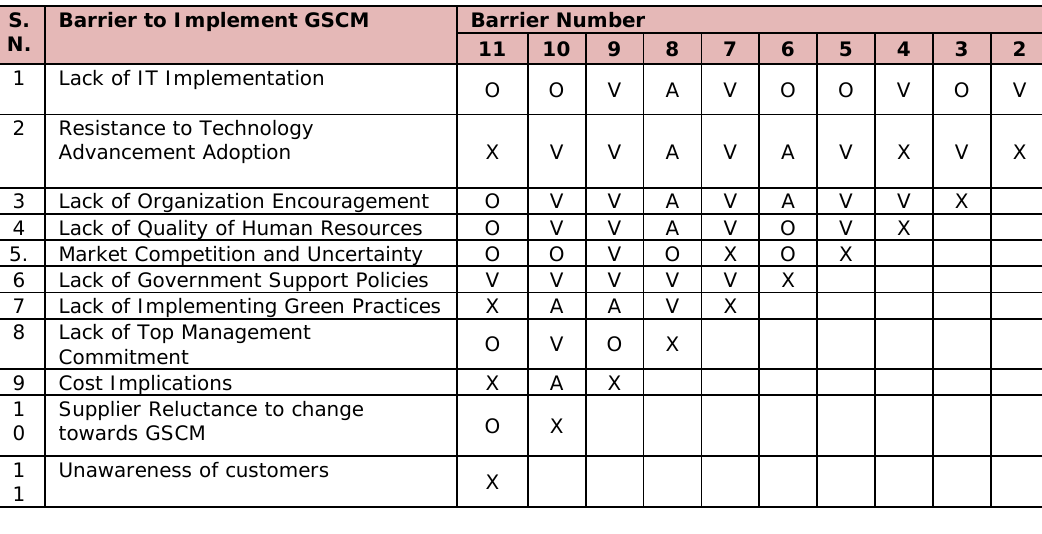
Table 3. “Structured Self Intersection Matrix (SSIM) for Barriers to Implement GSCM in Indian Automobile